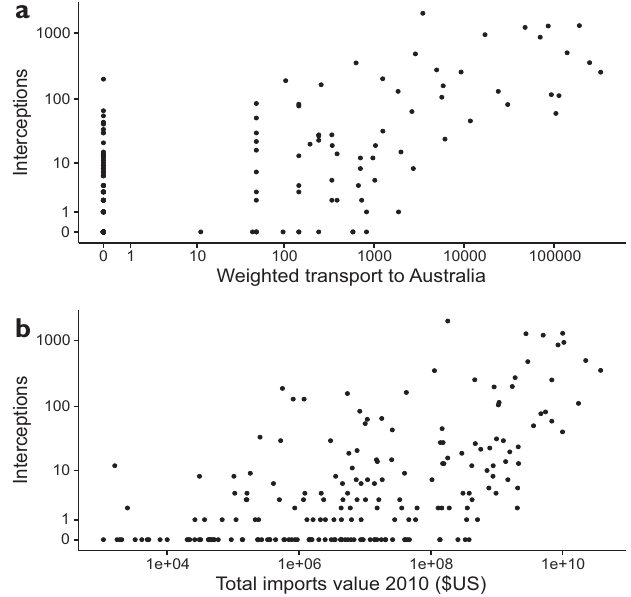
Figure 4. Ant interception counts correlated with ( a ) weighted transport volumes and ( b ) import value in 2010, by country. Correlation coefficients 0.36 for transport volume and 0.40 for import value.